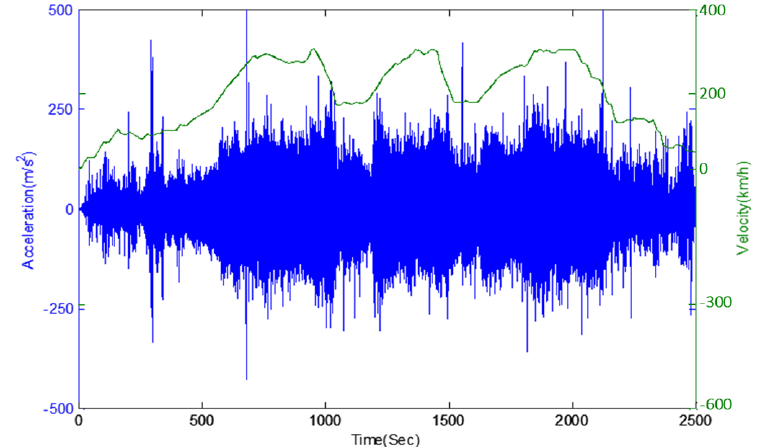
Figure 5. The vibration acceleration data on the axle box with velocity (km / h): (blue line) the vibration acceleration, (green line) the velocity data during the driving at 300 km / h. The maximum impact of the vibration acceleration occurred between about ± 30 ( ± 300 m / s 2 ) and about ± 50 G ( ± 500 m / s 2 ) during the period when the high-speed train traveled at 300 km / h.